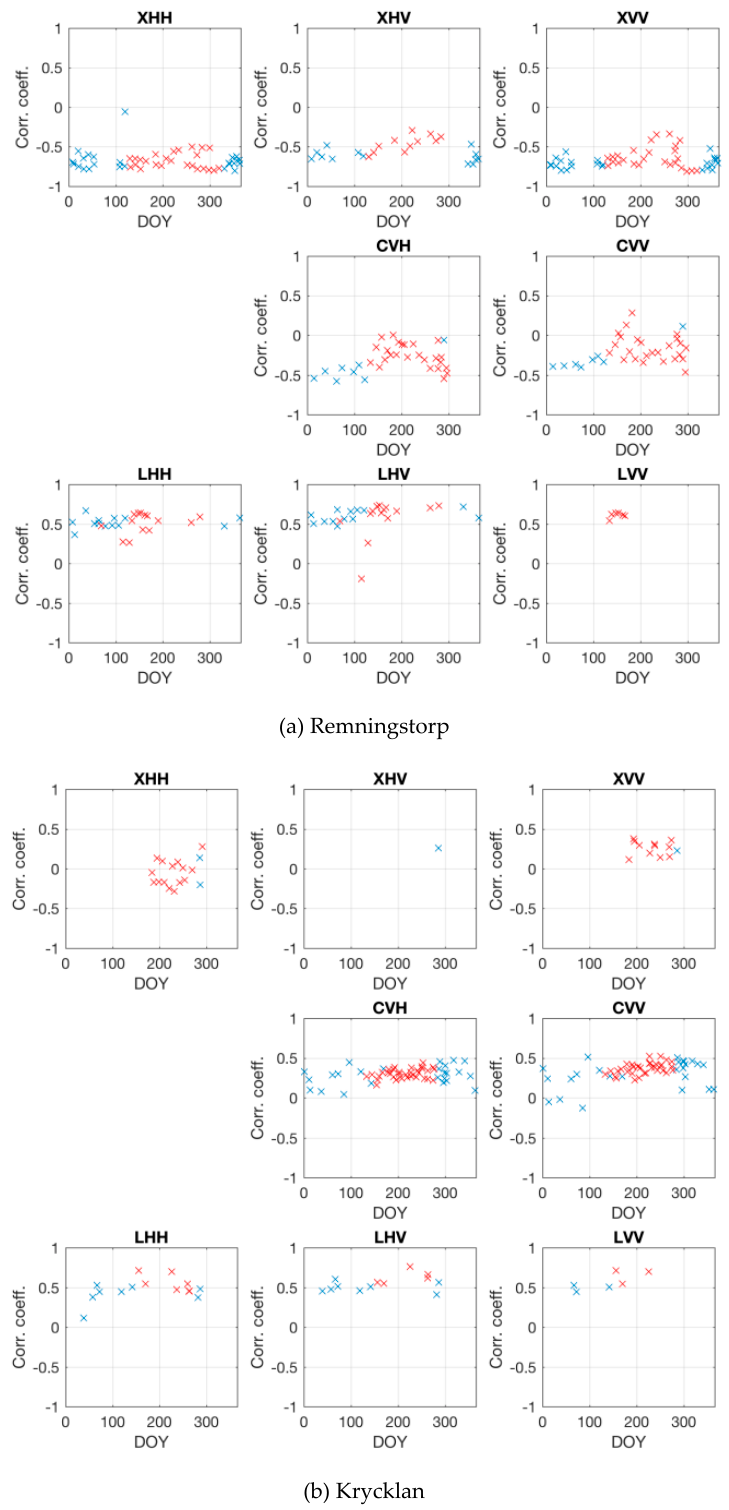
Figure 3. Correlation coefficient of SAR backscatter and stem volume as a function of day-of-year, (DOY) at Remningstorp for 48 inventory plots ( a ) and Krycklan for 325 inventory plots ( b ). Colors refer to the minimum temperature on the day of image acquisition. Crosses are blue or red depending whether the temperature was below or above 3 °C.